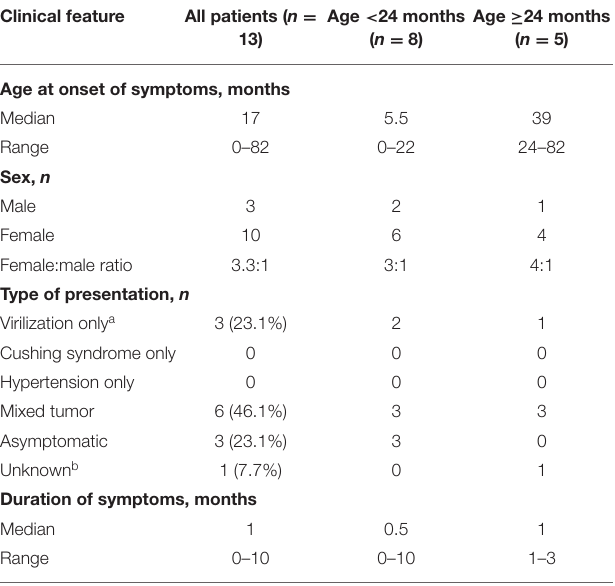
TABLE 1 | Clinical features at presentation of 13 pediatric patients with adrenocortical tumors. Clinical feature